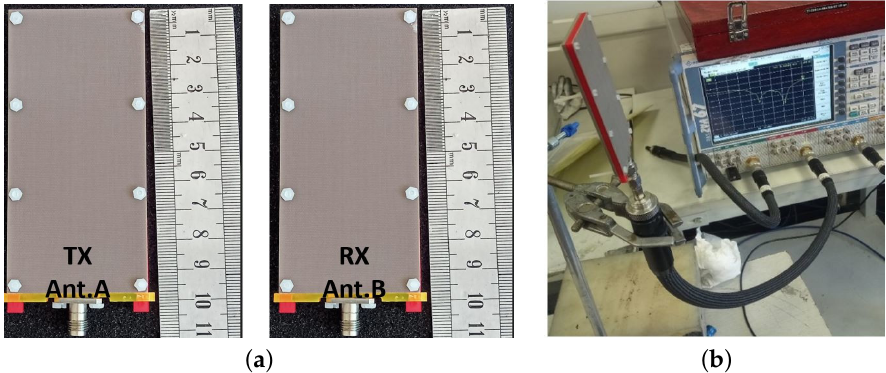
Figure 9. ( a ) Fabricated LWA prototype with external connections (ant. and ant. B) ( b ) S 11 test setup.